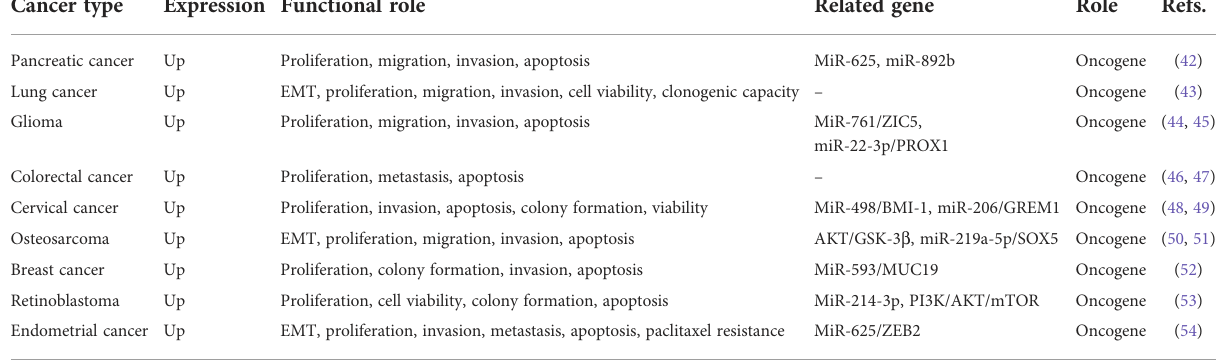
TABLE 1 Functional characterization of circ_0007534 in various cancers.